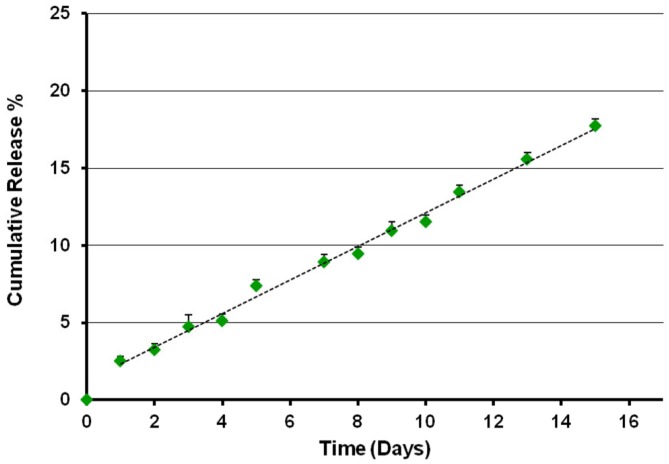
Release profile of temporin B from TB-CS-NPs in SPB pH 7.4, 37°C. After a short lag time, the system displayed a progressive linear release of the loaded active agent.